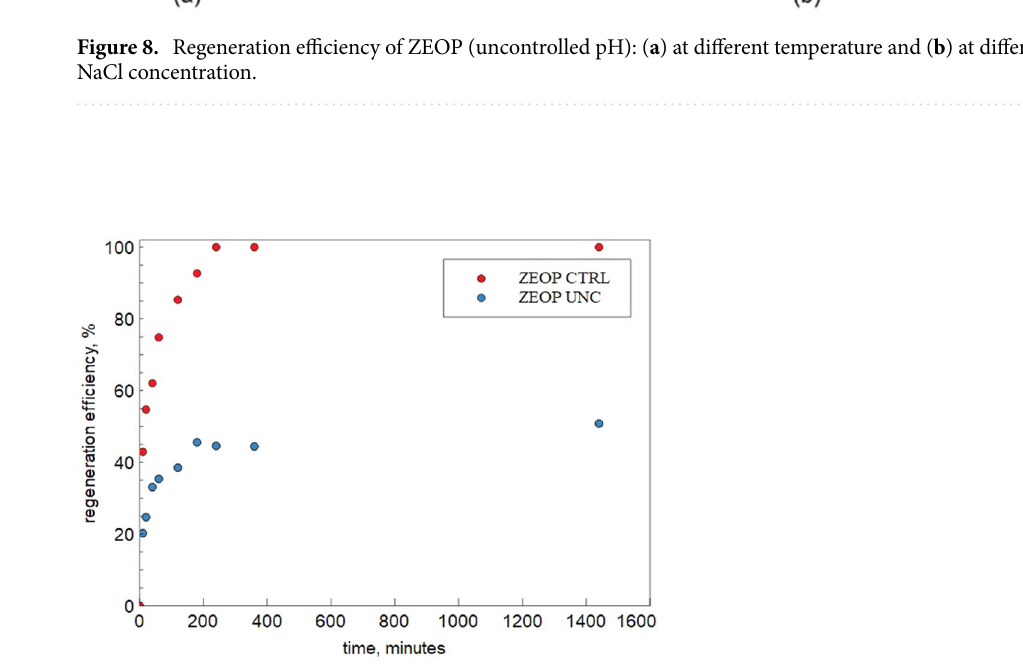
Figure 9. Regeneration efficiency of ZEOP UNC (uncontrolled pH) and ZEOP CTRL (pH = 5) at 25 °C with a 1 M NaCl